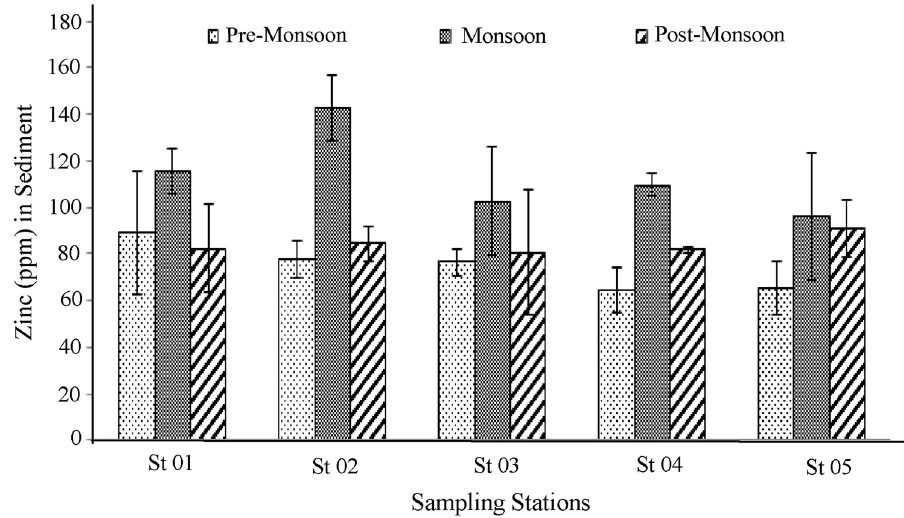
Fig. 3 Sediment zinc concentra- tion (± SD) variation at different seasons in different sampling stations of Sundarban mangrove